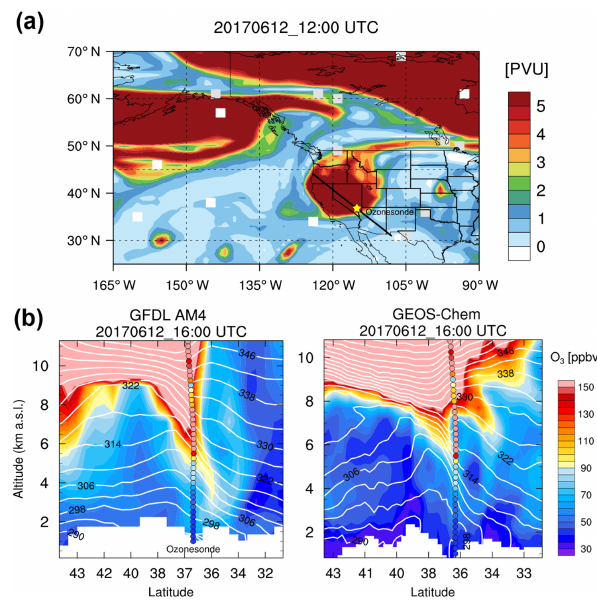
Figure 7. (a) Potential vorticity at 250hPa on 12 June calculated from the NCEP-Final (FNL) reanalysis (PVU: 10 − 6 m 2 s − 1 Kkg − 1 ) ; (b) vertical distributions of O 3 (color shading) and isentropic surfaces (white lines) along a transect crossing Nevada (black line on PV map) simulated with GFDL- AM4 (left) and GEOS-Chem (right) on 12 June. The color-coded circles denote ozonesonde observations at Joe Neal (star on the PV